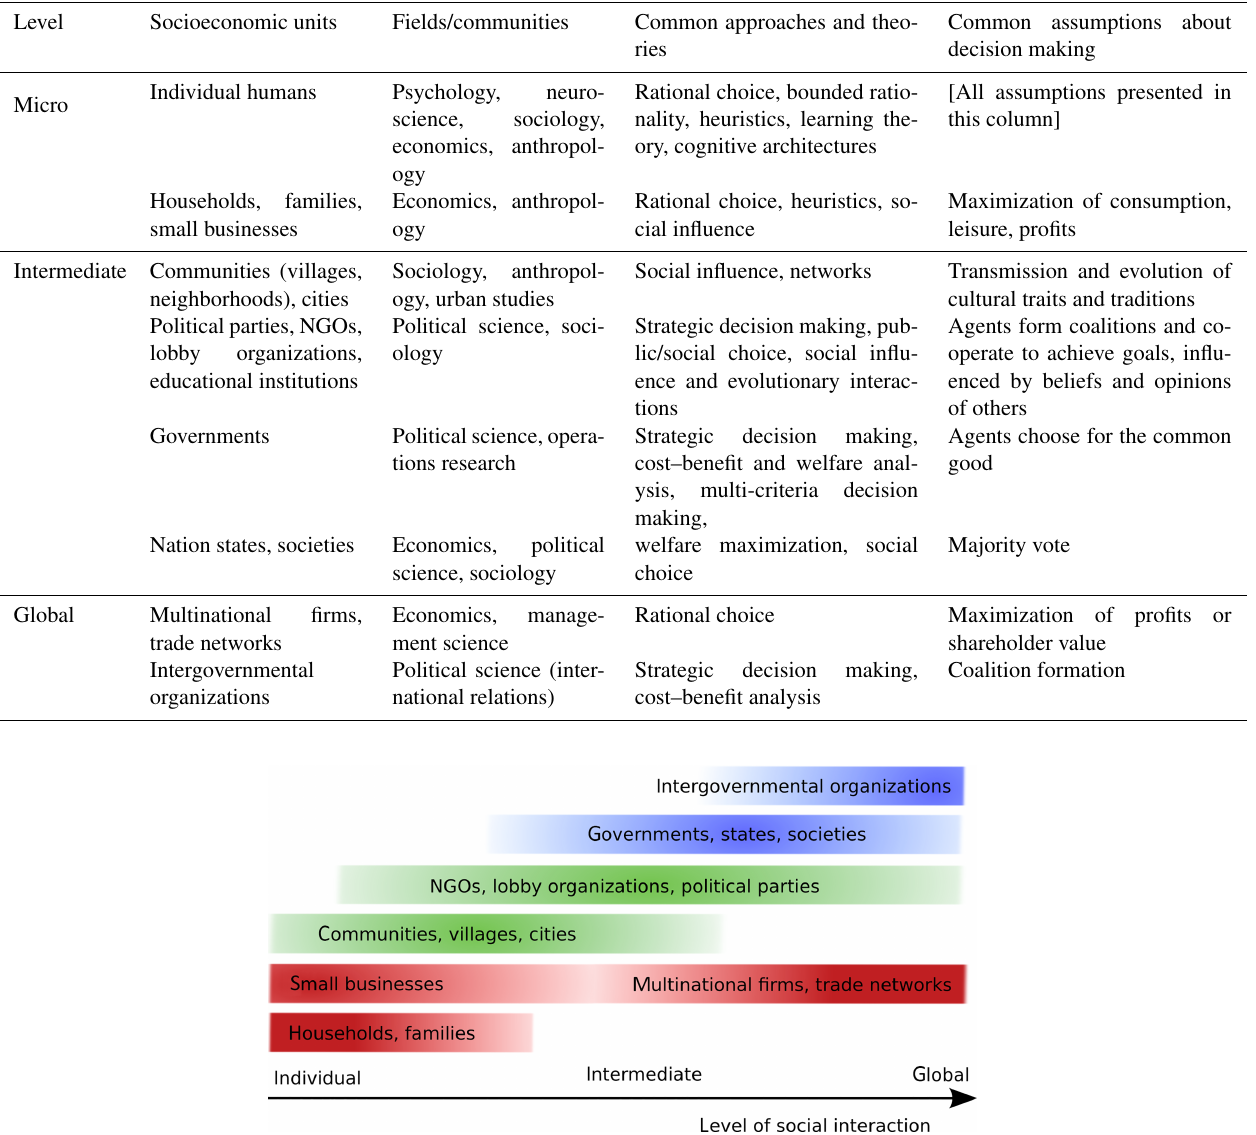
Figure 2. Socioeconomic units and their corresponding level and